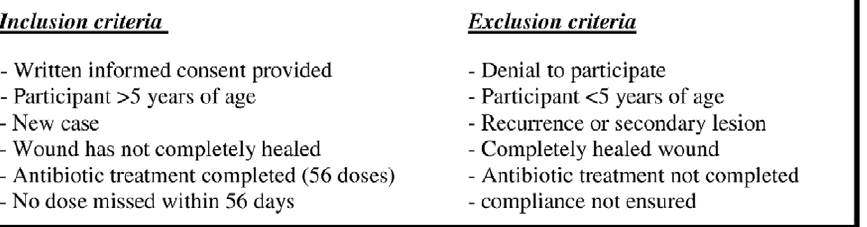
Figure 2. Enrolment criteria for the post-treatment study population. Figure 2 describes enrolment criteria for IS 2404 PCR confirmed BUD patients with incomplete wound healing (collection of swab samples feasible) who presented at Agogo Presbyterian Hospital, Ghana ( n =7), following completion of 56 doses of rifampicin and streptomycin administered within eight weeks. None of the eligible study participants was excluded.